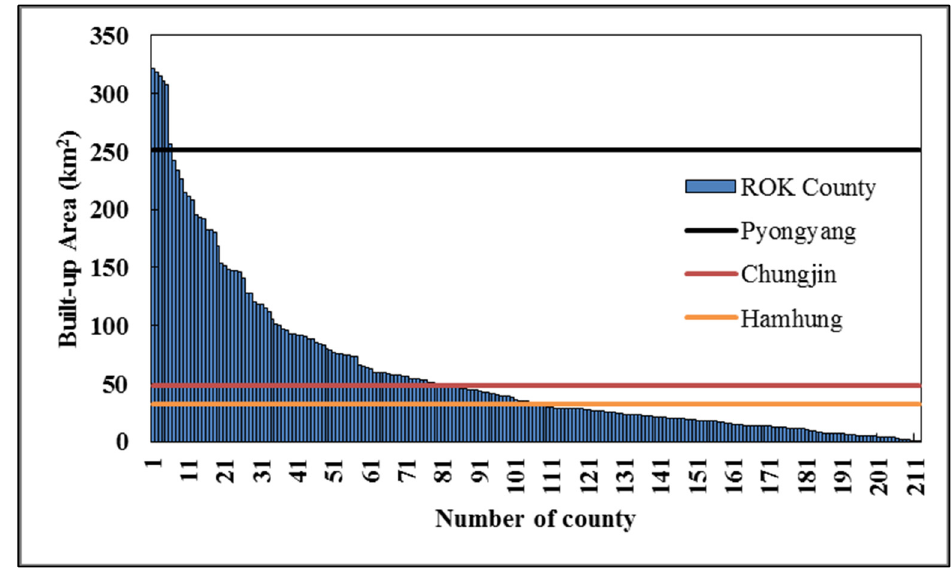
Figure 8. Comparison of urban built-up area between DPRK and ROK.